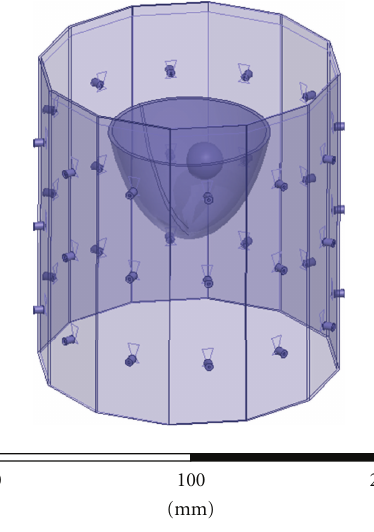
Figure 14: HFSS CAD numerical breast phantom of Example 2. The inclusion is 2cm in diameter with relative permittivity and conductivity contrasts of 2:1. The skin layer is 2mm